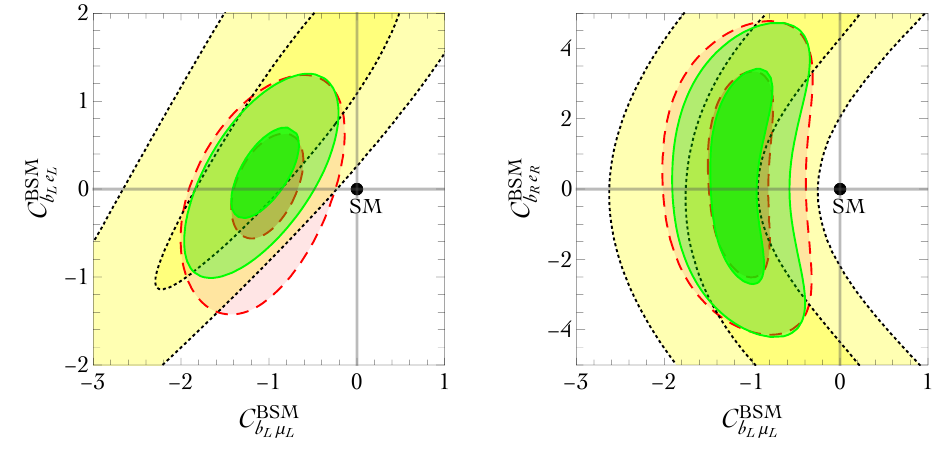
Figure 4 . Fits allowing one operator involving muons (horizontal axis) and one involving electrons (vertical axis): left-handed in the left panel, and right-handed in the right panel. Regions and contours have the same meaning as in (cid:12)gure 3: ‘clean’ data can be (cid:12)tted by an anomaly in muons or electrons; ‘hadronic sensitive’ data favour an anomaly in